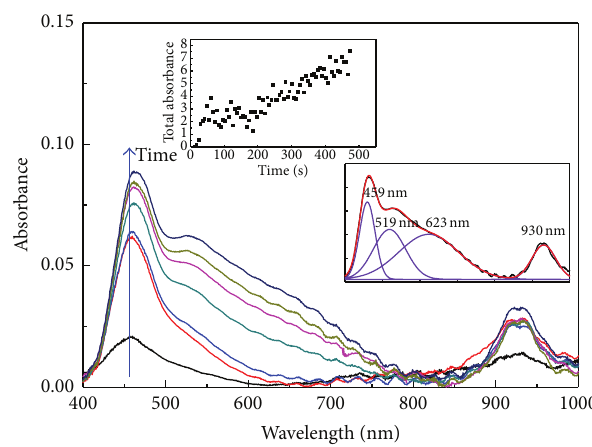
Figure 2: Absorbance spectra taken at regular interval of 50 seconds. Right inset: Gaussian analysis of the spectrum acquired after 500 s as an example of data treatment. Left inset: total optical absorbance versus LA irradiation